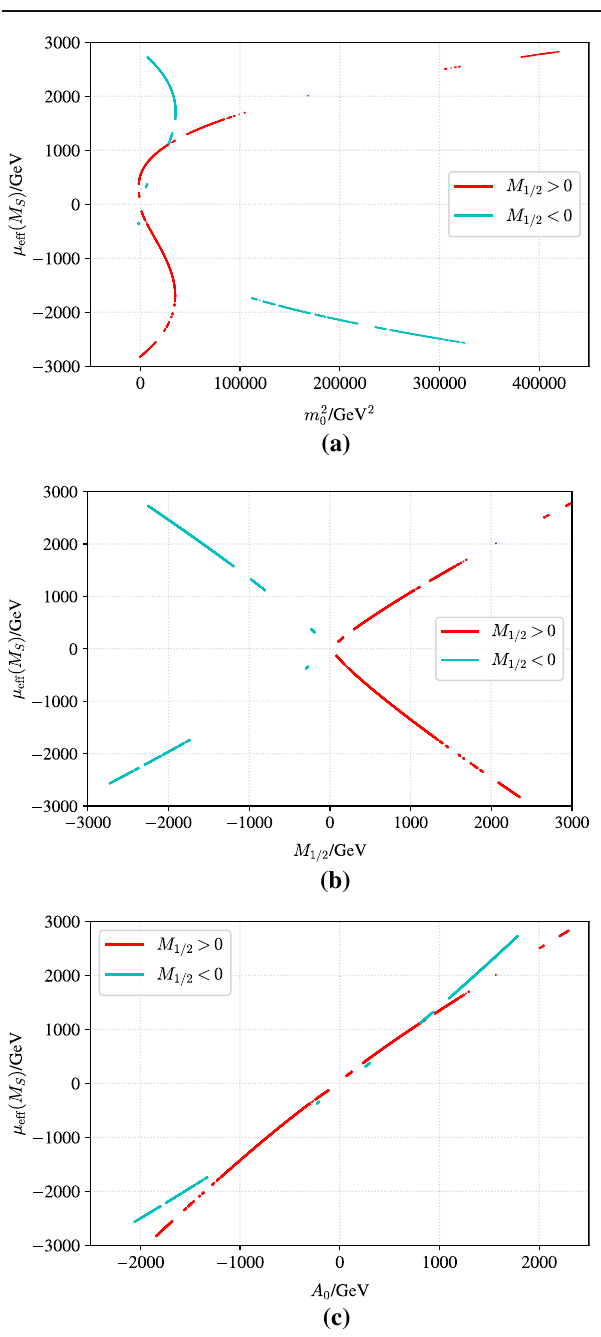
Fig. 12 The CNMSSM GUT parameters as functions of μ eff . The dimensionless input parameters are t β ( M Z ) = 9, λ( M S ) = 0 . 04, and κ( M ) = − 0 . 013. The solutions with positive and negative M S plotted in different colors for κ < 0. The term with positive sign is only approxi- mately quadratic in v s and takes the shape of a slightly tilted parabola. It is the sum of both terms which causes the func- (μ ) to behave in the observed non-monotonic way. tion m 2 eff 0 The relation between M 1 / 2 and μ eff is nearly linear, as one would expect for two parameters of mass dimension one.